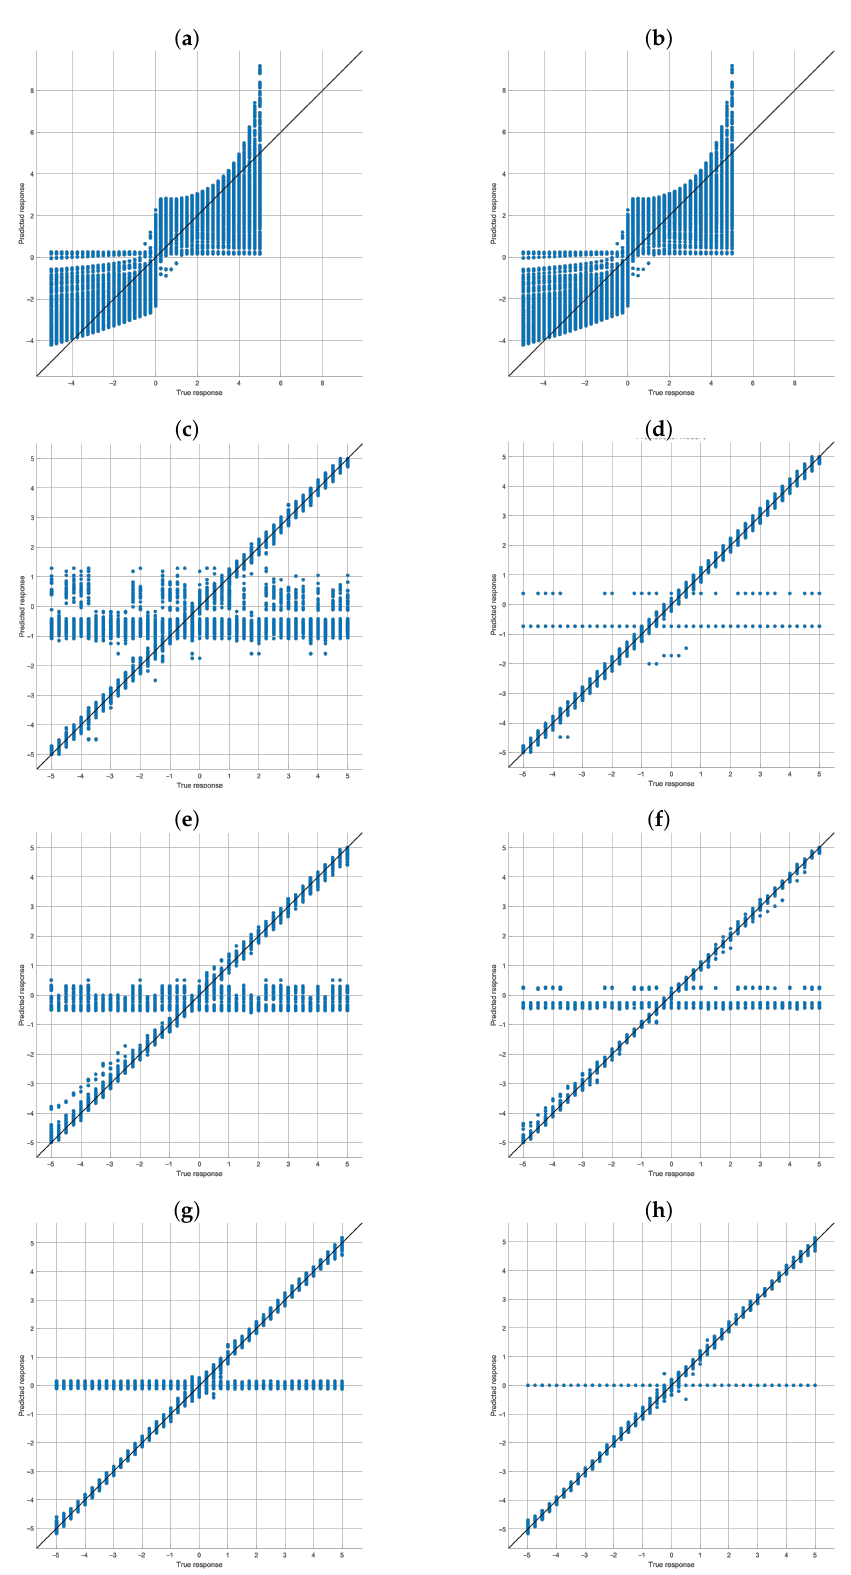
Figure 6. Comparison between the predicted response (x-axis) and the real value (y-axis) for four of the regressors of Table 3 ( a ) Linear regression validation, ( b ) Linear regression test, ( c ) Optimizable tree validation, ( d ) Optimizable tree test, ( e ) Optimizable ensemble validation, ( f ) Optimizable ensemble test, ( g ) Wide neural network validation and ( h ) Wide neural network